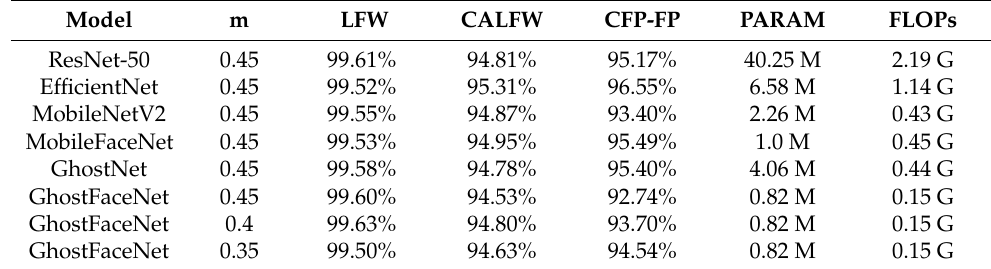
Table 10. Performance comparison of GhostFaceNet with other models. Results are in % and higher number indicates better